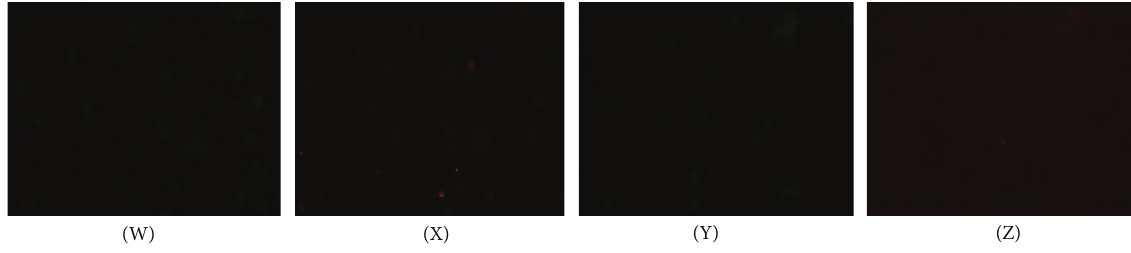
Figure 4: Evaluation of apoptosis in NRK-52E cells by AO/EB staining after 48 hours of treatment with IC 50 values of HWE, CWE, MWE, AWE, EAA, AAA, PAE, AAE, MAE, 30 C, and MT of Ruta and 5-FU. Cells were observed under fluorescence microscope at 200x. (A) Control (untreated); (C) 5-FU; (E) HWE; (G) CWE; (I) MWE; (K) AWE; (M) EAA; (O) AAA; (Q) PAE; (S) AAE; (U) MAE; (W) 30 C; (Y) MT were observed under acridine orange filter and (B) control (untreated); (D) 5-FU; (F) HWE; (H) CWE; (J) MWE; (L) AWE; (N) EAA; (P) AAA;